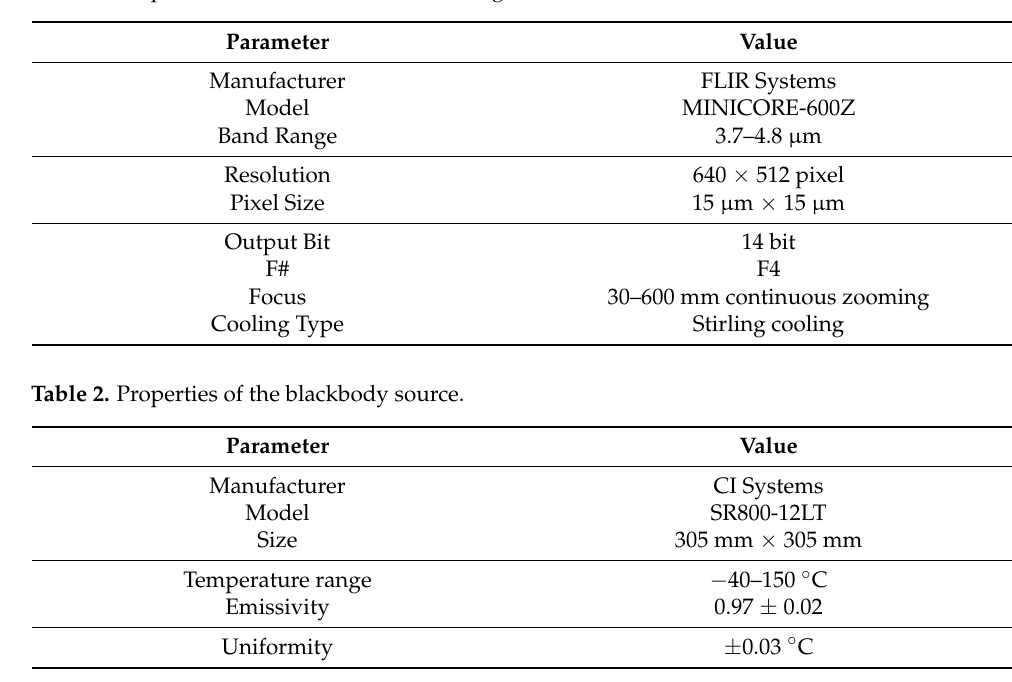
Table 1. Properties of the infrared thermal imager.